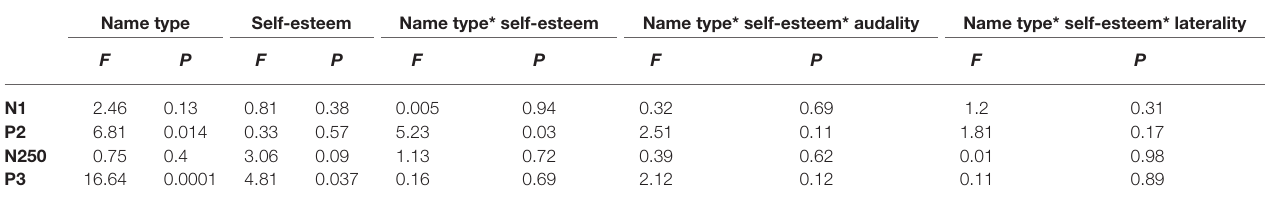
TABLE 2 | The results of ANOVA for the amplitudes of N1, P2, N250 and P3